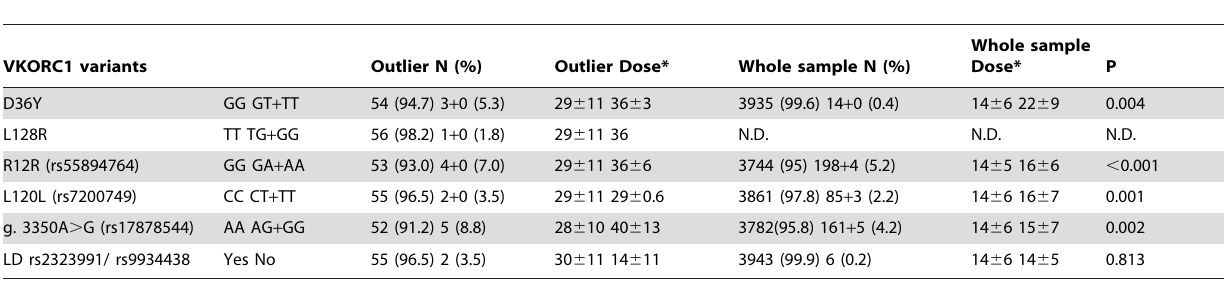
Table 2. New variants of VKORC1 identified in this study and their impact on acenocoumarol dose in whole sample (3949 patients) and in 57 outlier